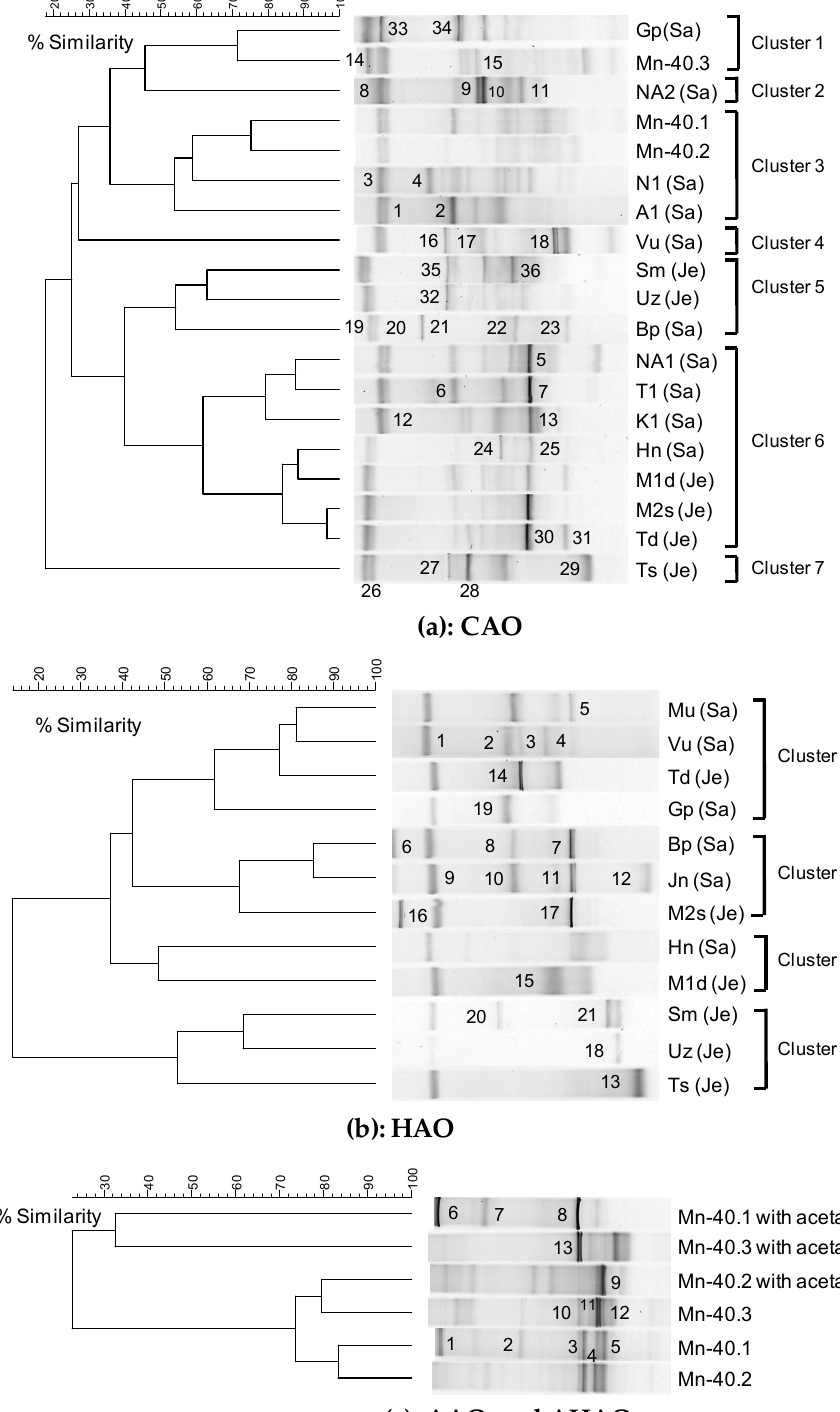
Figure 1. UPGMA cluster analysis of bacterial 16S rRNA gene-based DGGE profiles (30-55% denaturant gradient) of different types of arsenite-oxidizing enrichments, using Pearson correlation analysis as measure of identity. (a) CAO, (b) HAO, and (c) AAO and AHAO, derived from the same groundwater samples as we studied previously. The enrichment IDs refer to the location of the drinking water well (see Table 1). Numbers refer to the position of excised bands. Enrichments were assigned to clusters on the basis of >50% similarity.